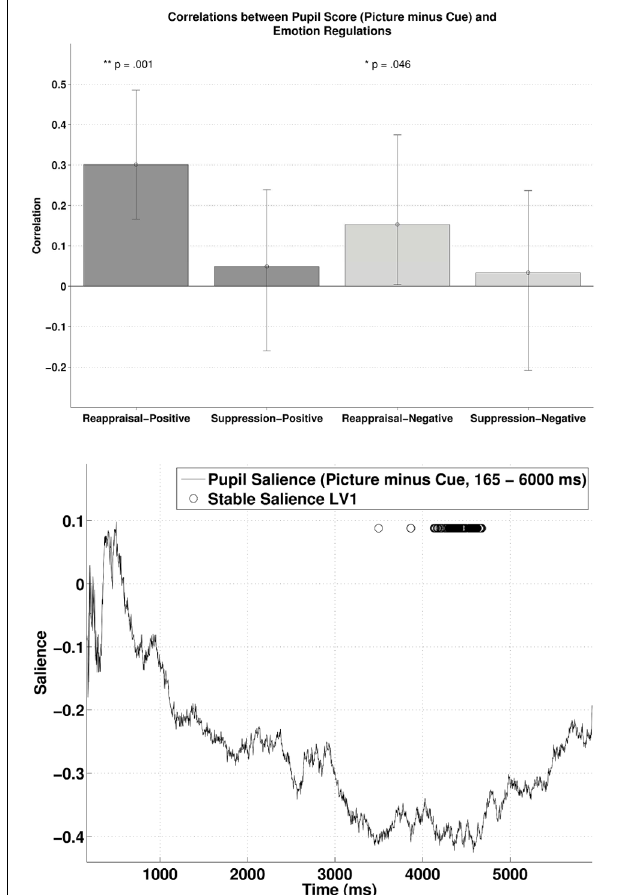
FIGURE 4 | The upper panel shows the correlations between participants’ pupillary responses and the ERQ scores in Latent Variable 1 during picture presentation. Error bars represent boot-strapped 95% confidence intervals. The lower panel shows that the saliences are in general negative, implying that the reappraisal correlations are interpreted as: the higher the rating, the smaller the pupillary responses (or alternatively, a tendency from dilation to constriction).